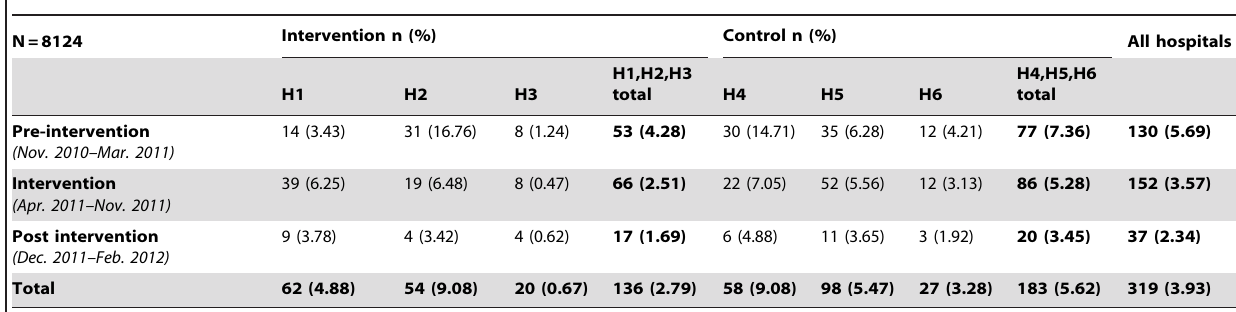
Table 4. Puerperal infections in women.